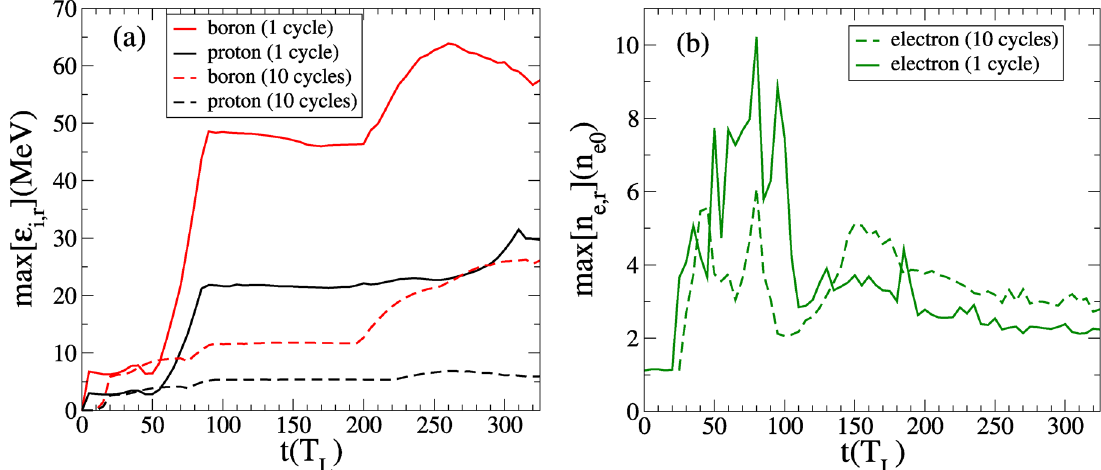
Figure 7. ( a ) Maximum radial ion energies and ( b ) maximum electron densities, as a function of time. In continuous (dashed) lines, with a single (10) cycle pulse. In black (red), protons (Boron ions) and in green,